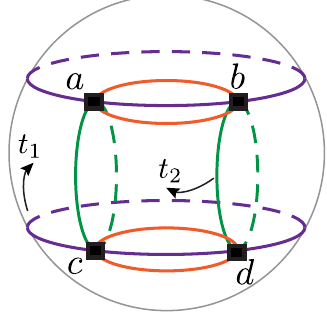
FIG. 13. Time sequence in Fig. 3 projected to three- dimensional space at t ¼ − ∞ . Triple points are marked a , b , c , d . Lines show the pairwise intersections of projected world- sheets. Purple lines, F and G worldsheets; orange lines, F and H ; green lines, G and H . The projected G worldsheet in this figure takes the form of the sphere; H and F take the form of tori (not shown). The directions t 1 show the time ordering of contribu- ; 2 tions to projection from worldsheets G , H , and so clarify to which Tlk some triple point contributes [see after Eq. (33)]. For IJK example, at point c , t 2 shows that projection of H at this point comes at later times, so after F , while t 1 shows that G comes from earlier times, so before both F and H , altogether contributing to Tlk . This process has the same triple linking number as the HFG one in Fig.